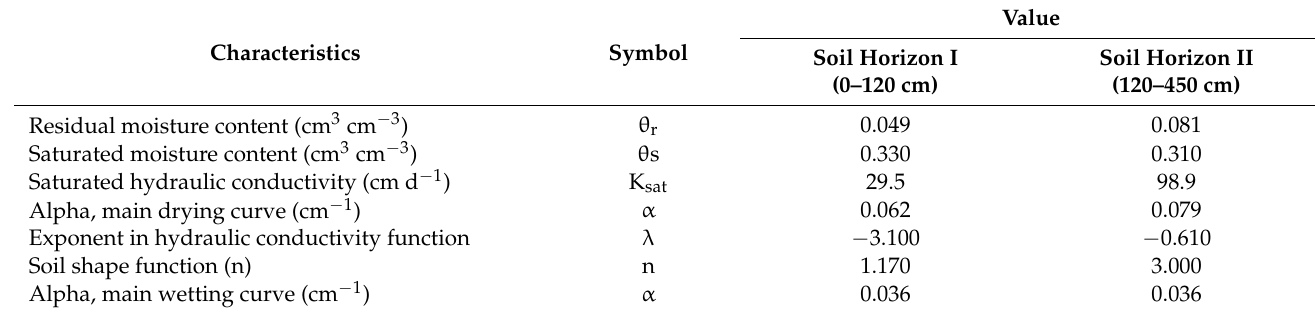
Table 1. Values of hydraulic parameters used for the SWAP-ANIMO simulation.